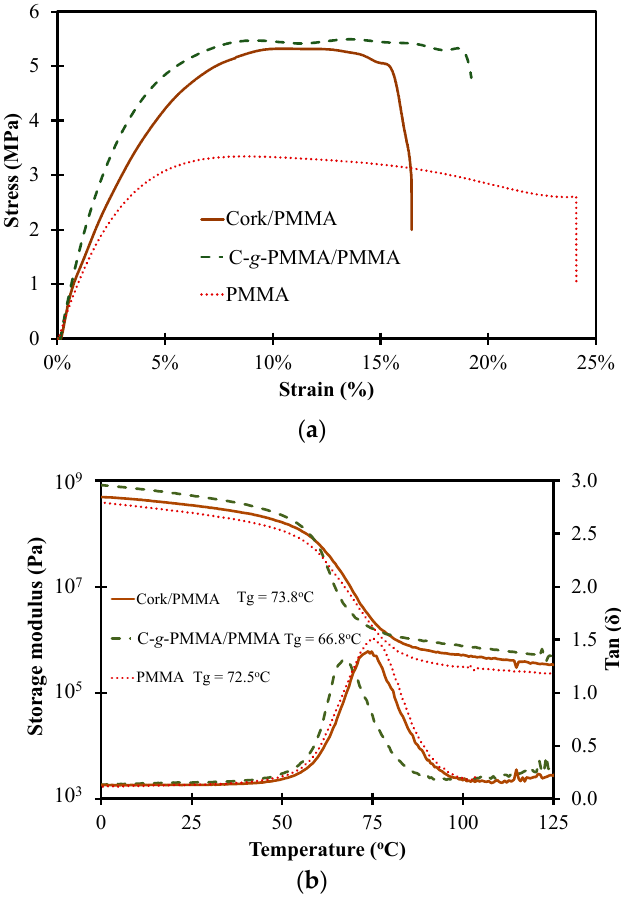
Figure 6. Static ( a ) and dynamic ( b ) mechanical properties of PMMA, Cork/PMMA and C- g -PMMA/PMMA filaments. Table 3. Mechanical properties of PMMA, Cork/PMMA and C- g -PMMA/PMMA filaments.